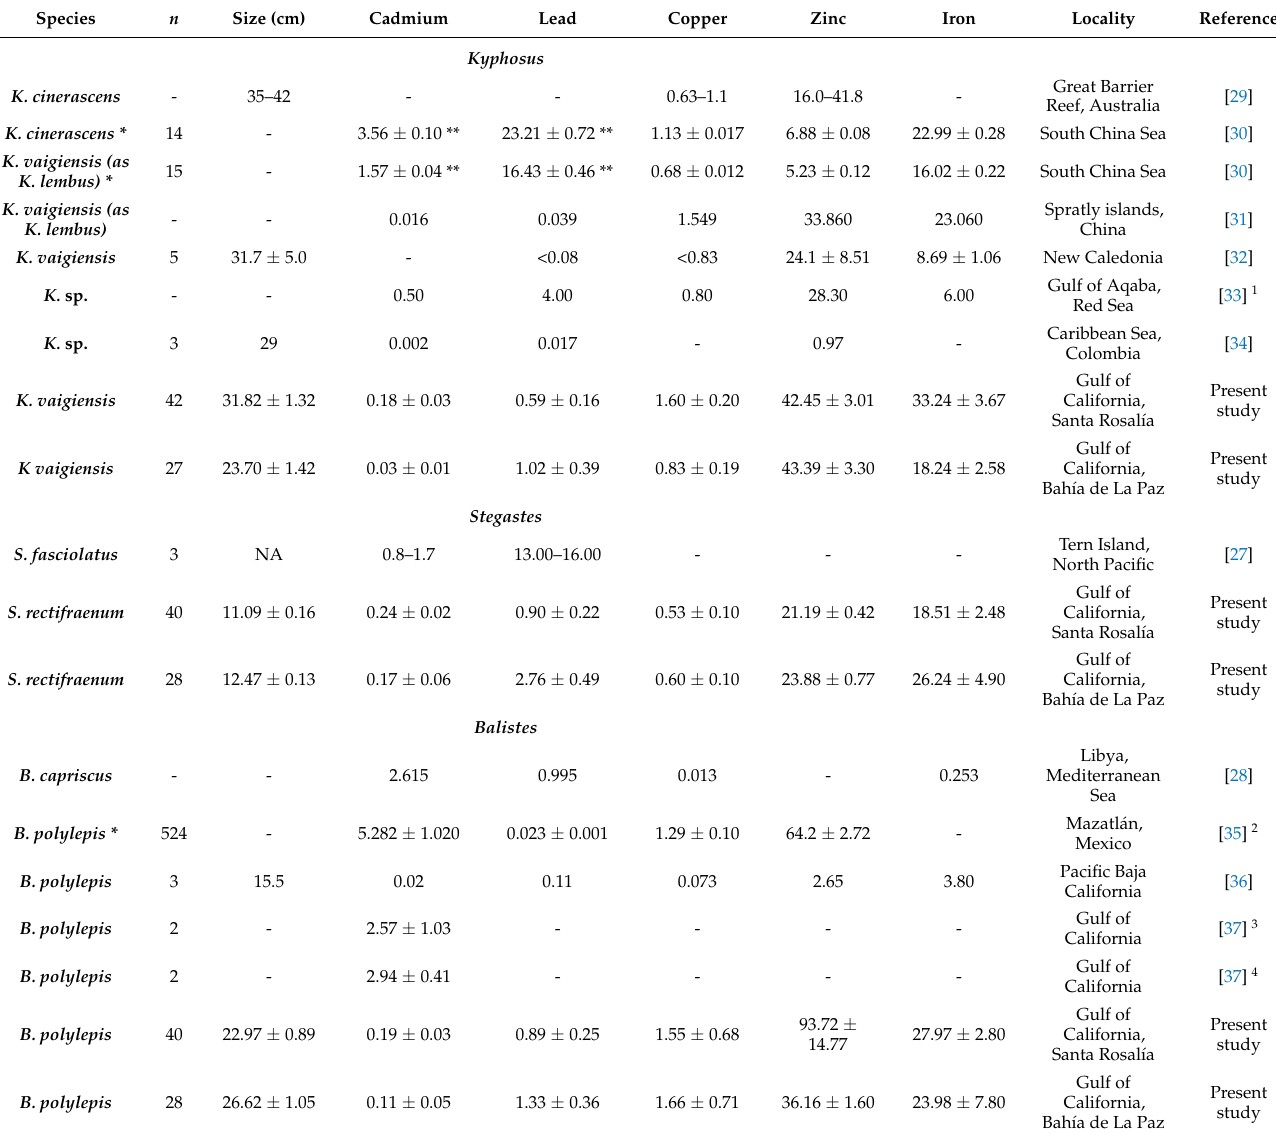
Table 1. Concentration (average ± standard deviation or minimum and maximum) of cadmium, lead, copper, zinc, and iron ( µ g g − 1 dry weight) in muscle of fish of the genera Kyphosus , Stegastes , and Balistes . Species n Size (cm) Cadmium Lead Copper Zinc Iron Locality